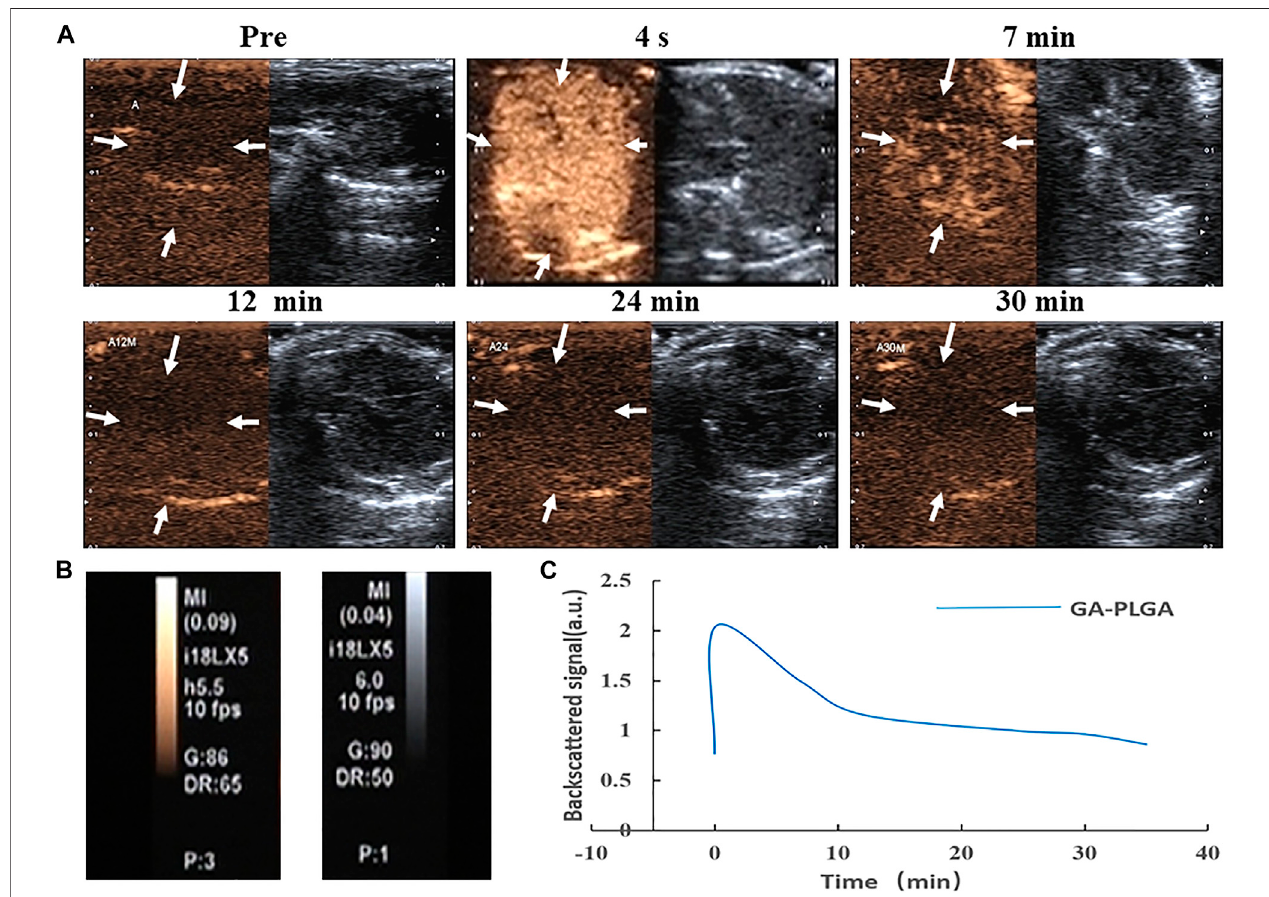
FIGURE 2 | (A, B) Ultrasonic images of GA porous-lipid/PLGA MBs. (C) Changes in signal strength in the liver. After injection of GA porous-lipid/PLGA MBs, the liver imaging was rapidly enhanced, the signal gradually decreasing after 7 min and completely disappearing after 30 min.